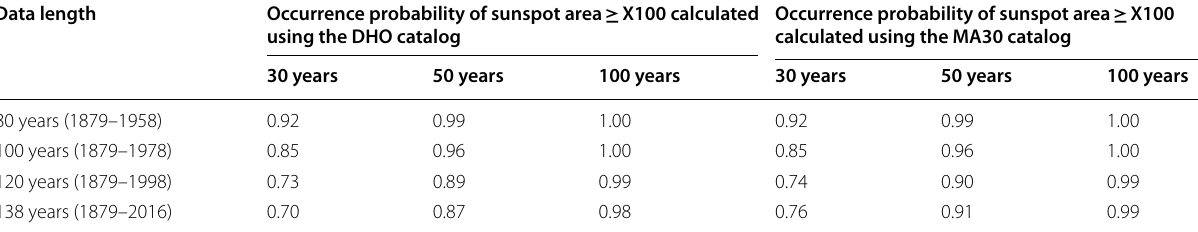
Table 5 Probabilities of a SXR flare ≥ X100 for next 30-, 50-, and 100-year periods for 80-, 100-, 120-, and 138-year data sets in the DH and MA20